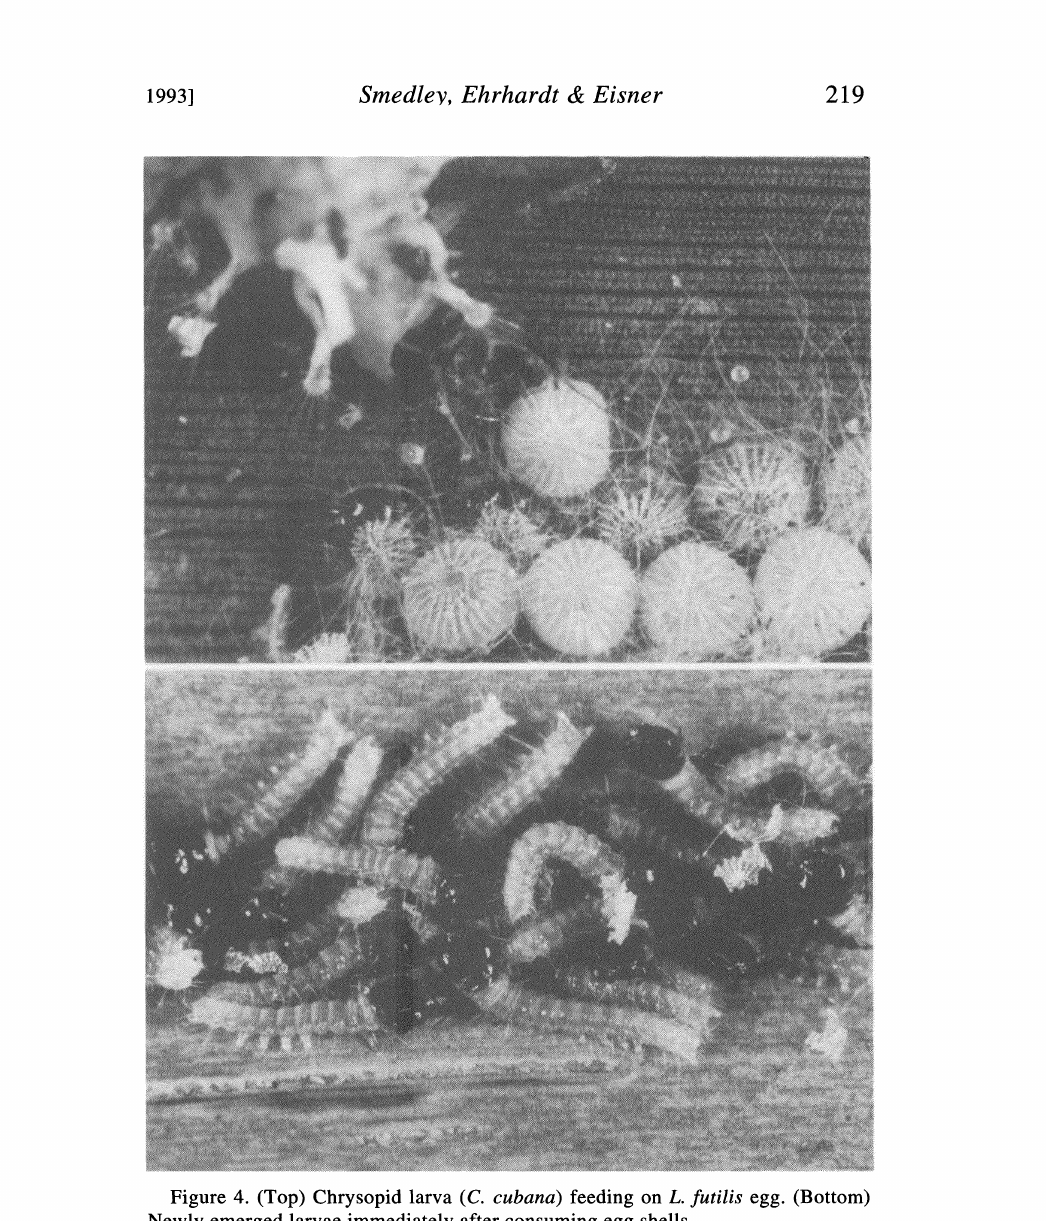
Figure 4. (Top) Chrysopid larva (C. cubana) feeding on L. futilis egg. (Bottom) Newly emerged larvae immediately after consuming egg